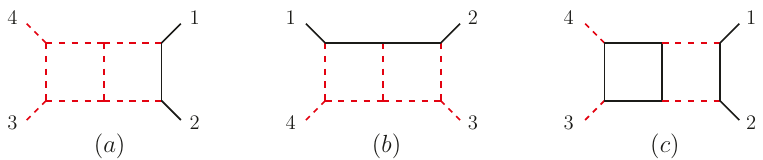
Figure 5. Master integral topologies with maximal number of propagators (7) that appear in the leading colour 2-loop amplitude for ¯ ttgg . Black-solid lines represent massive particles, red-dashed lines represent massless particles.